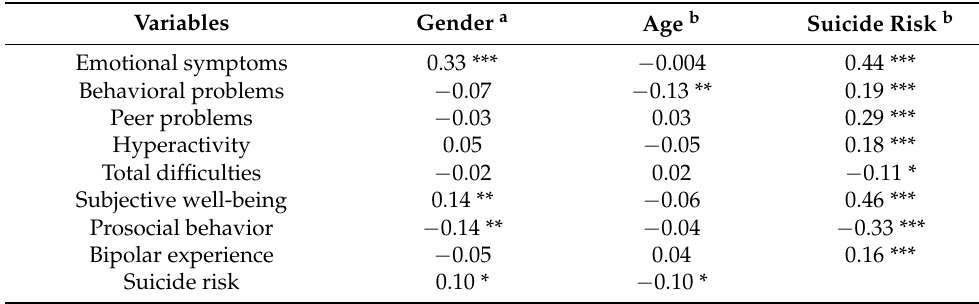
Table 2. Correlational analysis in adolescents with bipolar experiences ( N = 467). Variables Gender a Age b Suicide Risk b Emotional symptoms 0.33